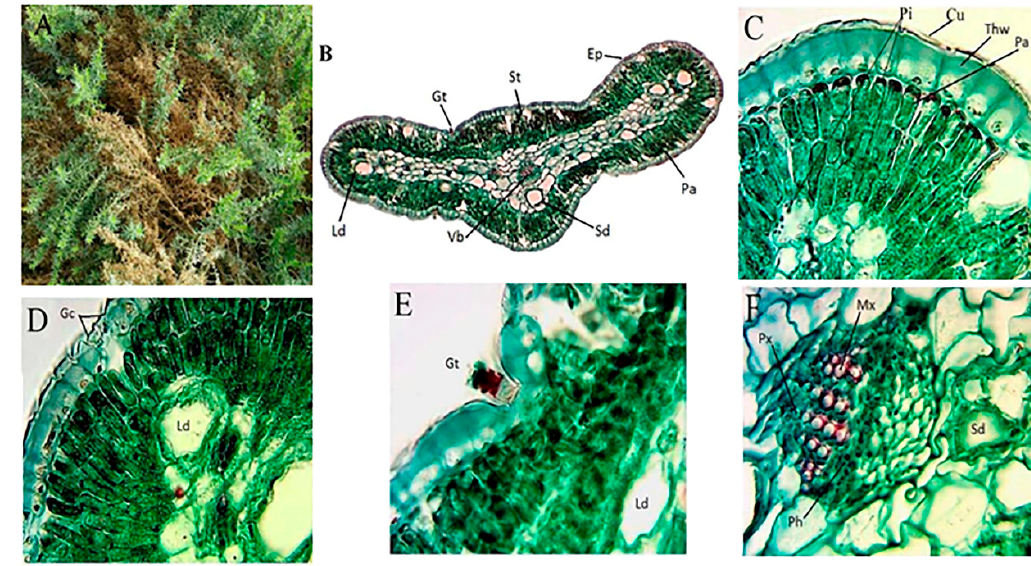
Figure 1. Morphology and anatomy of A. monosperma leaf. ( A ) Morphology; ( B ) A transverse section in leaf showing the general